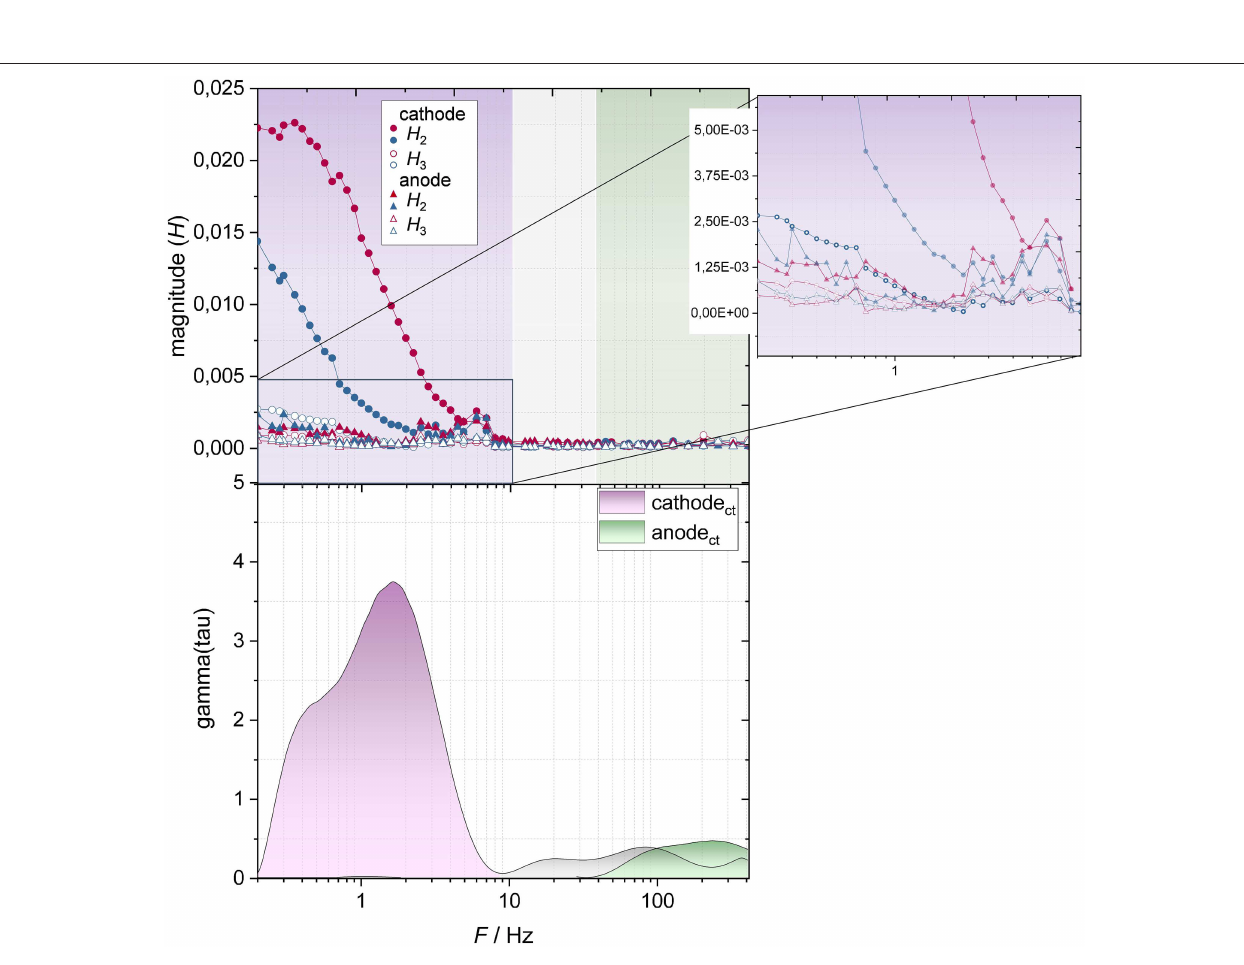
Frontiers in Energy Research |